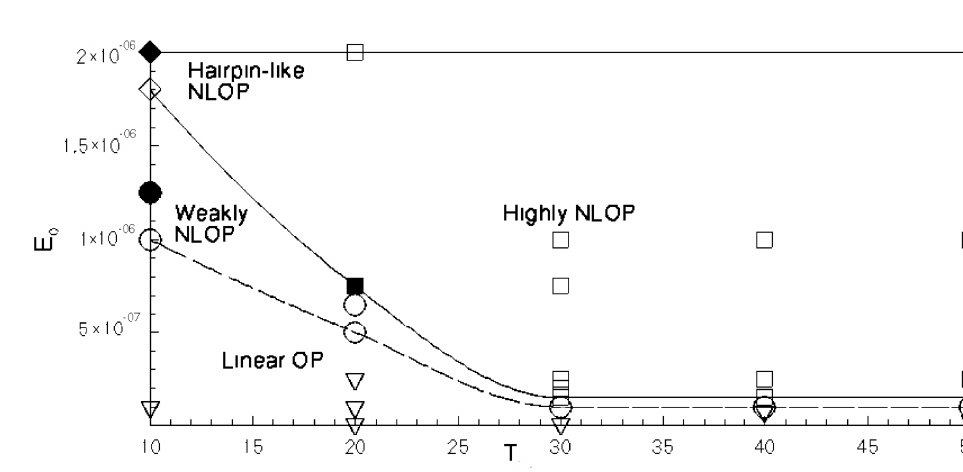
Figure 5. Optimizations performed depending on T and E 0 : triangles for linear optimals, circles for weakly nonlinear optimals, squares for highly nonlinear optimals, and diamonds for hairpin-like nonlinear optimals (the black symbols indicate optimal solutions which are shown in the following figures). The long-dashed line roughly represents the boundary between linear and weakly nonlinear solutions, whereas the solid line indicates the approximate energy threshold above which hairpin-like and highly nonlinear optimal perturbations can be found.Results are obtained for a plane Poiseuille